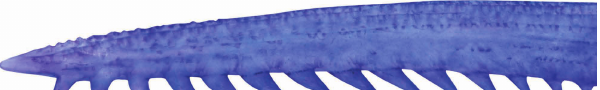
Fig. 4. Pectoral-fin spine of Corydoras guapore , ZUFMS- PIS 4000, 28.8 mm SL, showing the conical